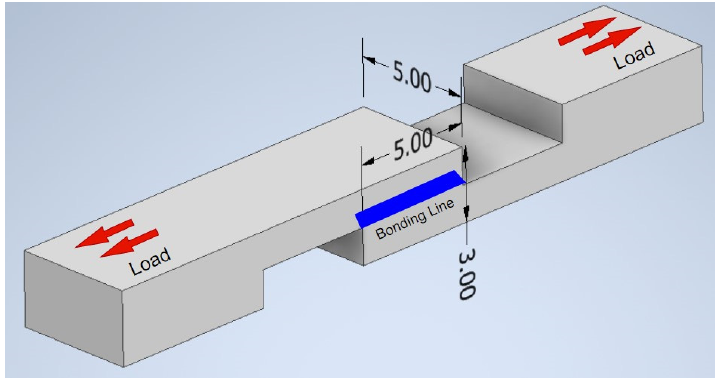
Figure 14. CAD model of lap shear specimen.